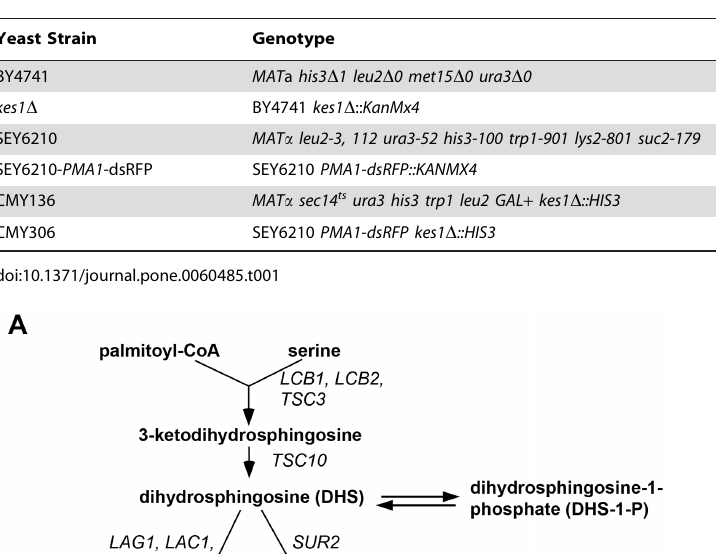
Table 1. Yeast strains used in this study.